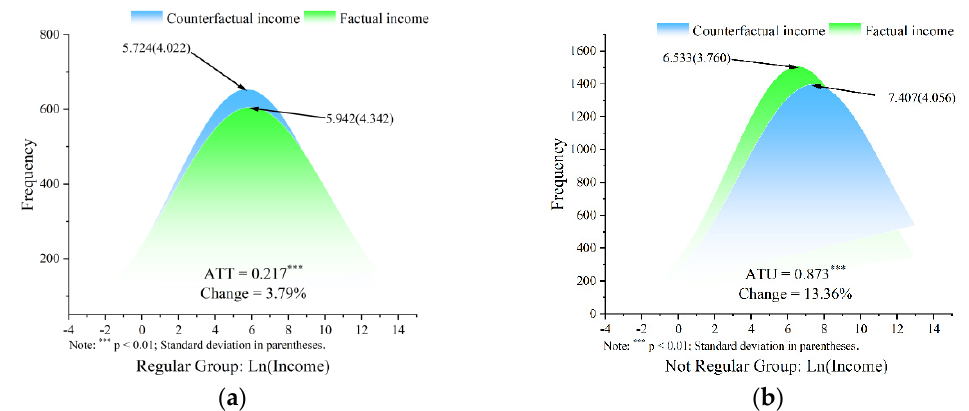
Figure 2. ( a ) Factual and counterfactual income of individuals with physical exercise habits; ( b ) factual and counterfactual income of individuals who do not have physical exercise habits.